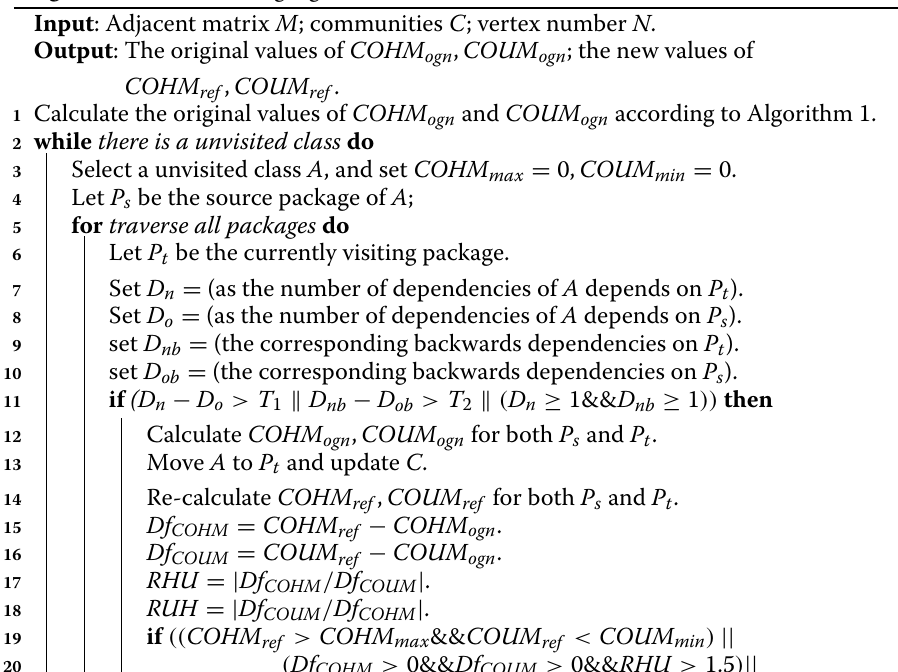
Algorithm 2: Refactoring algorithm base on our